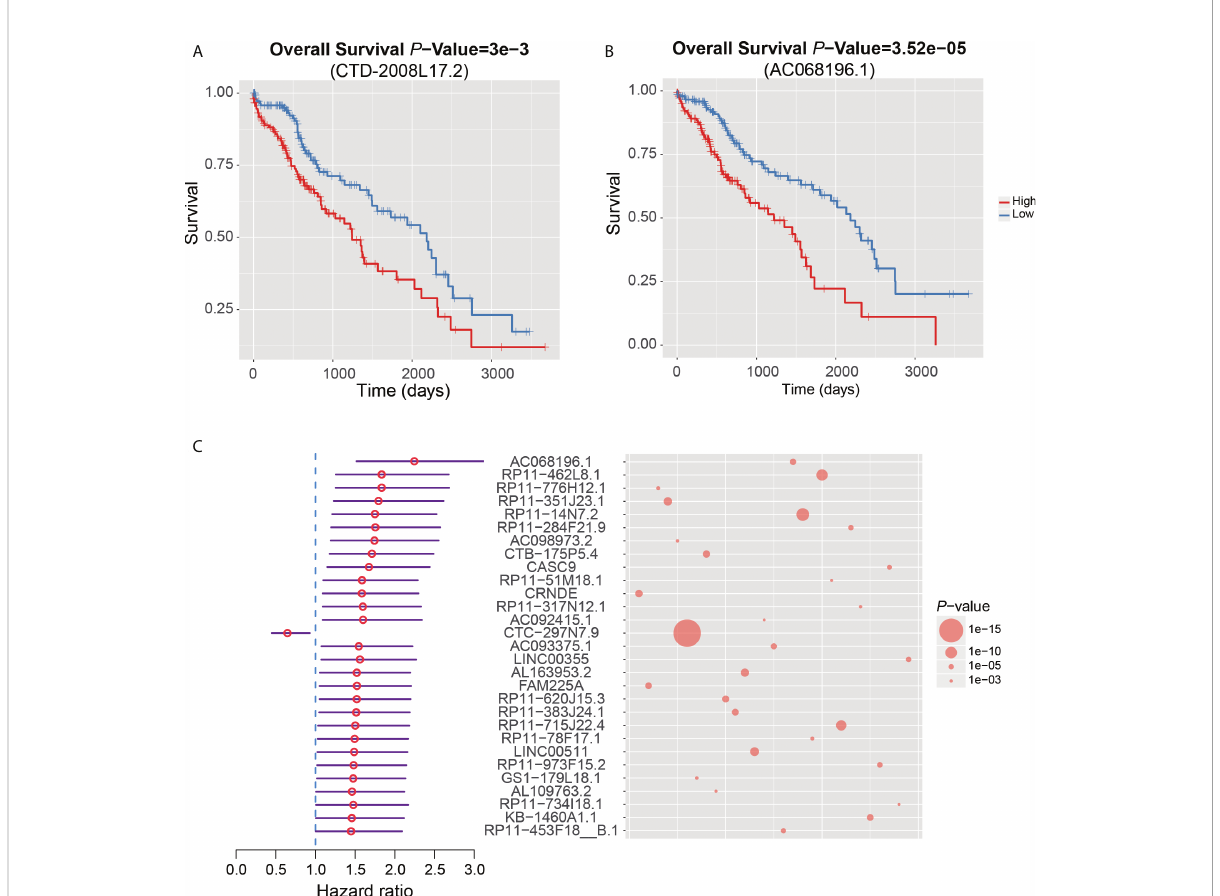
FIGURE 6 Clinical associations between dysregulated ncRNAs and HCC prognosis. The Kaplan – Meier curves show signi fi cant overall survival between HCC samples with high and low expression of CTD-2008L17.2 (A) and AC068196.1 (B) . (C) The 29 dysregulated lncRNAs that are signi fi cantly associated with HCC prognosis by both survival analysis of the TCGA dataset and differential expression analysis of HCC samples with good and poor prognosis from six HCC